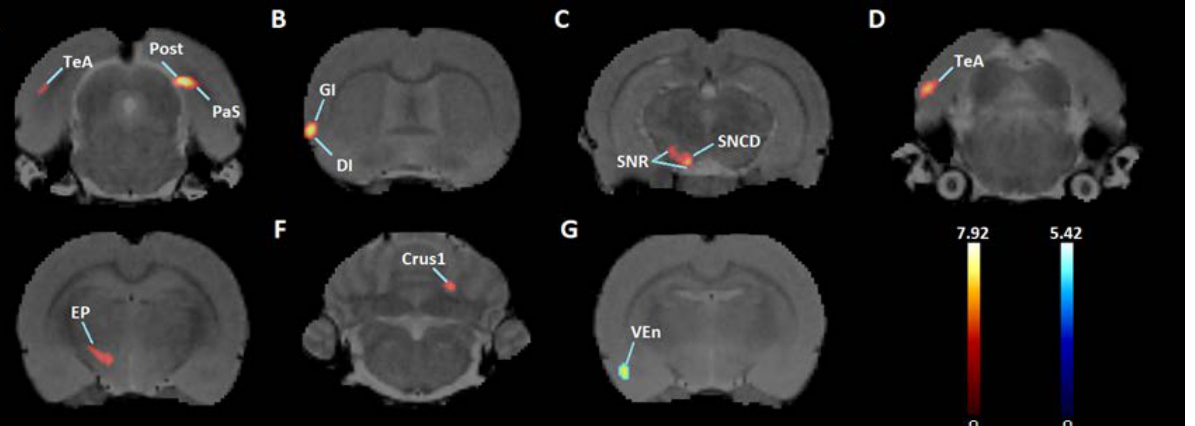
Figure 2. PET Images: Representative examples of a reconstructed PET image superimposed on an MRI template: coronal, sagittal, and horizontal (left to right).